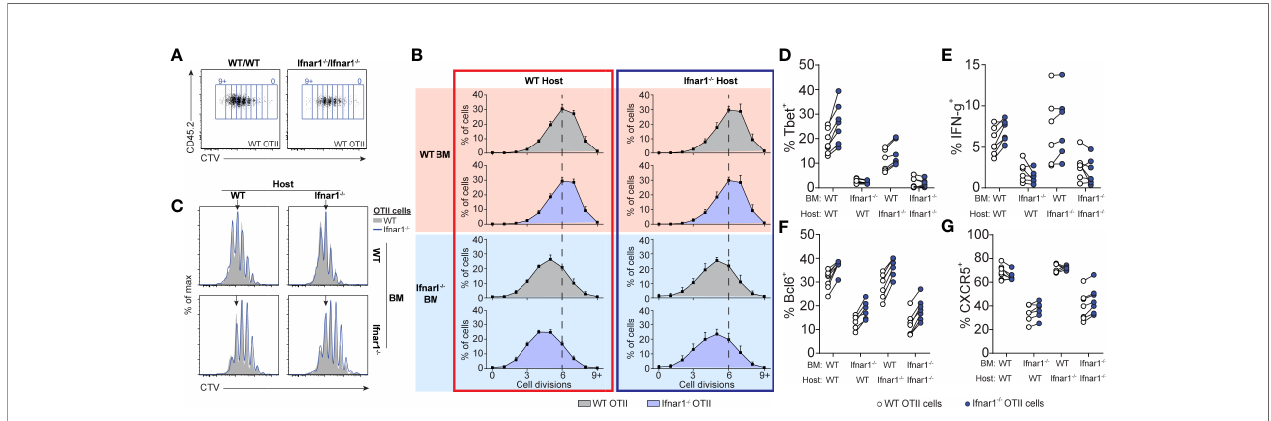
FIGURE 7 | Tfh- and Th1-cell development is supported by IFNAR-signaling in hematopoietic cells distinct from cognate CD4 T cells. Equal numbers (250 000) of CTV-labelled WT and Ifnar1 -/- OT-II cells were co-transferred into Ifnar1 -/- BM chimeric recipient mice and spleens were analyzed 3 days after immunization with OVA/poly I:C. (A) Representative CTV dot plots showing gating strategy of OT-II cells from mice receiving either WT or Ifnar1 -/- BM. (B) Representative CTV pro fi les of OT-II cells from all experimental groups. Arrows indicate median division in the full WT group. (C) Percentages (mean ± SD) of OT-II cells in indicated cell cycle number as determined by CTV-dilution. Verticle lines indicate median division in the full WT group. (D – G) Percentage of T-bet + (D) , IFN- g + (E) , Bcl6 + (F) , and CXCR5 + (G) WT and Ifnar1 -/- OT-II cells, respectively. Results are pooled from two individual experiments consisting of a total of 6-7 mice per group. Each pair of symbols represents one mouse (D – G)